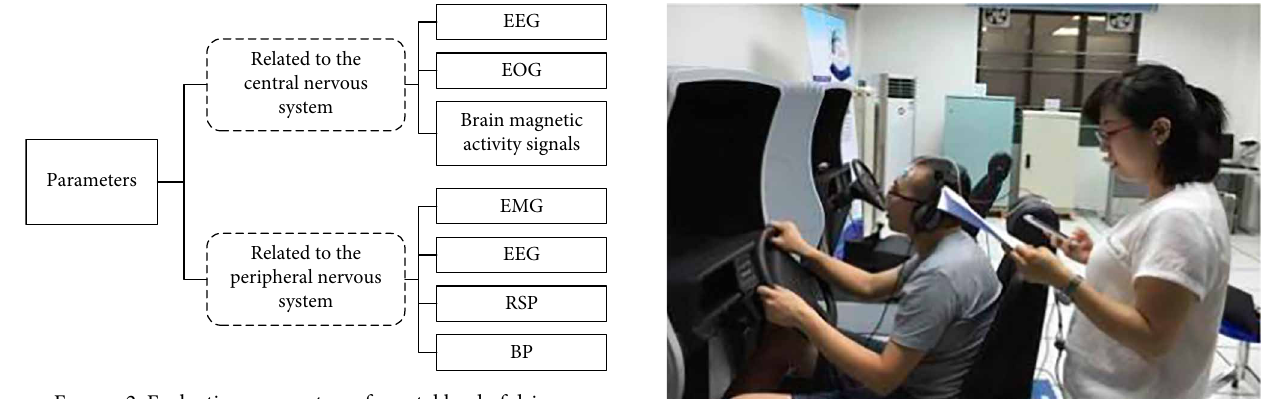
Figure 2: Evaluation parameters of mental load of drivers.